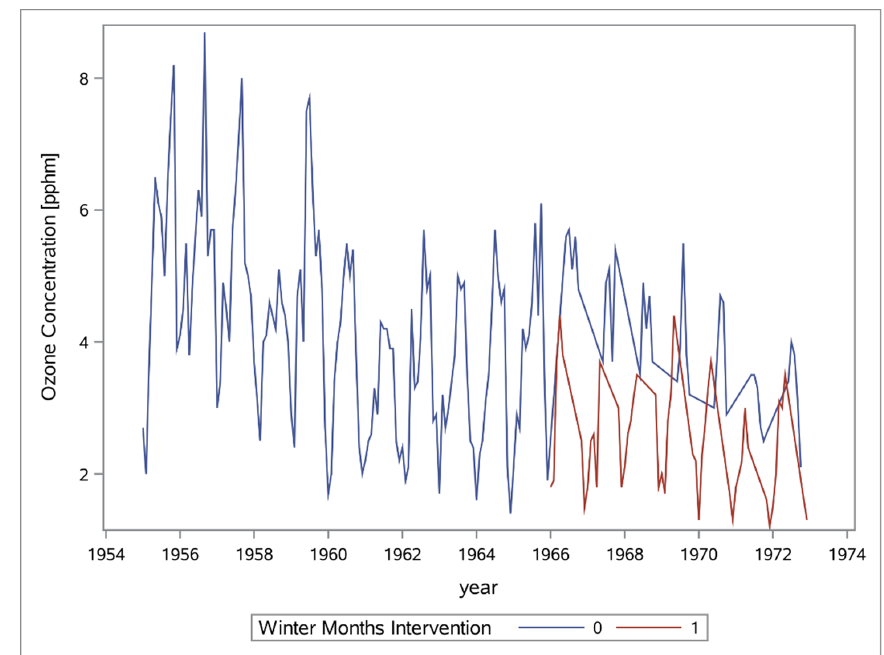
Figure 1. Ozone concentration in downtown Los Angeles from January 1955 to December 1972. Table 1. Summary of statistics of the ozone concentration. The units are in parts per hundred million (pphm).